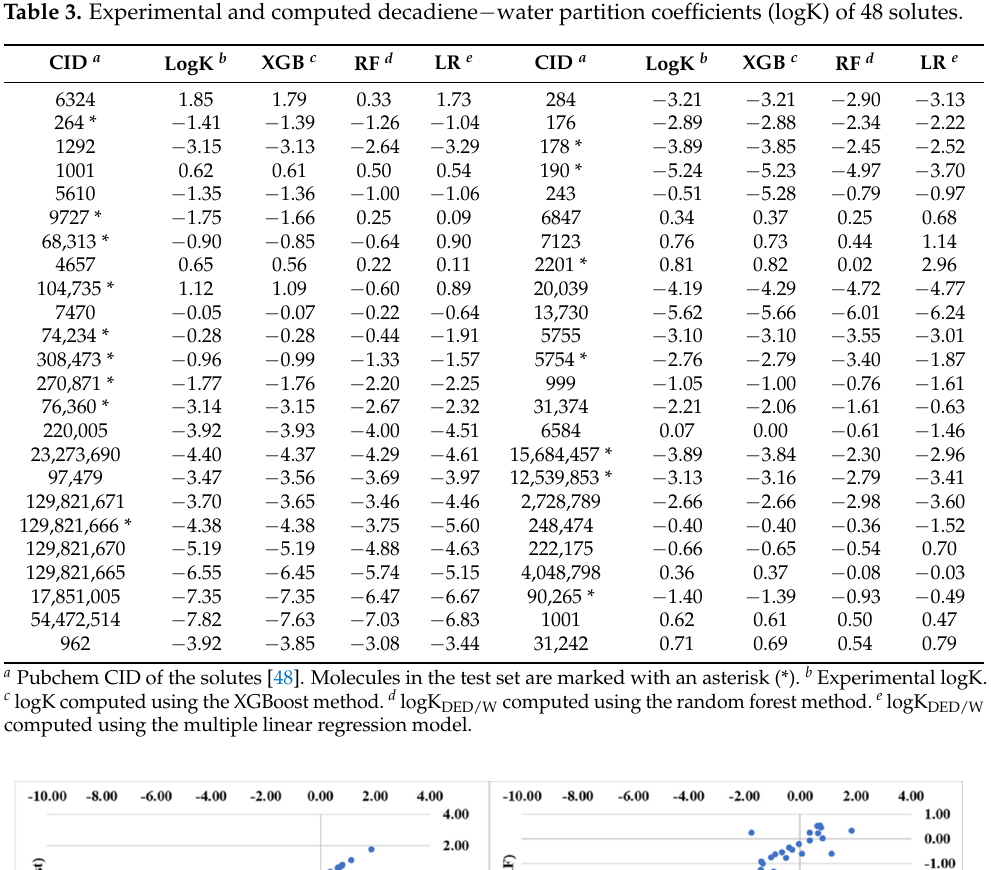
Table 3. Experimental and computed decadiene − water partition coefficients (logK) of 48 solutes.